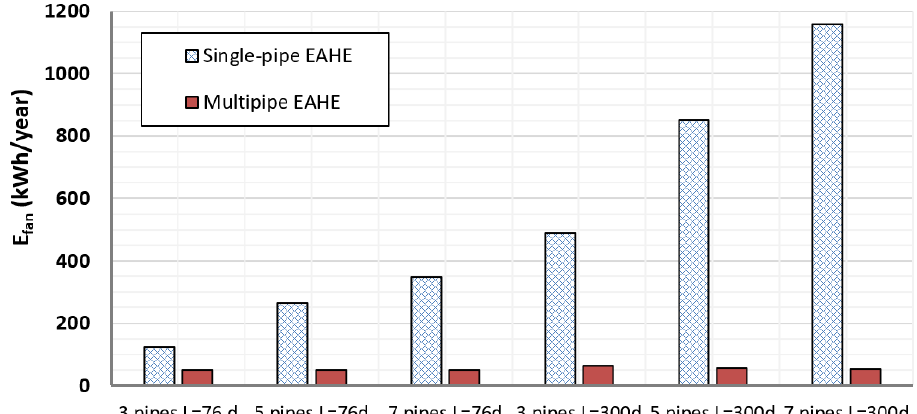
Figure 10. Full-year energy usage for a fan flowing air through an earth-to-air heat exchanger; system usage: scheduled (performance changes outside peak usage hours).